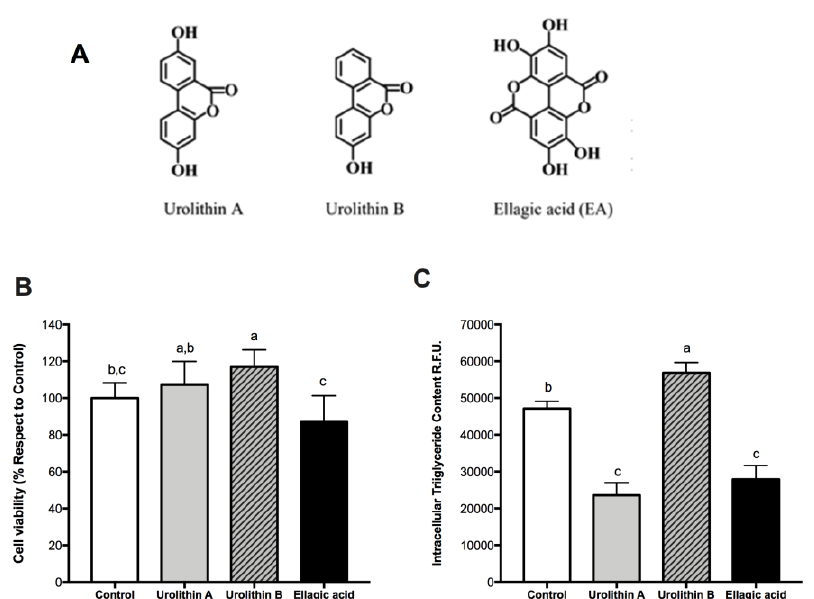
Figure 1. The effect of ellagic acid, urolithin A, and urolithin B on cell viability and intracellular triglyceride content in preadipocytes and mature adipocytes. ( A ) Chemical structures of ellagic acid and its derivatives urolithins A and B. ( B ) Cell viability of 3T3-L1 preadipocytes in control samples (0.025% dimethyl sulfoxide (DMSO)) and after 24 h treatment with 25 μM urolithin A, urolithin B, and ellagic acid. The values represent the mean ± SD ( n = 3) of three independent experiments conducted in duplicate. ( C ) Intracellular lipid accumulation in 3T3-L1 mature adipocytes after 8-day treatment with 25 μM of urolithin A, urolithin B, ellagic acid, and control (0.025% DMSO). Data are means ± SD ( n = 3) of three independent experiments conducted in triplicate. Different letters among bars denote significant changes among treatments and control ( p ≤ 0.05) performed by ANOVA and Tukey’s post hoc test.